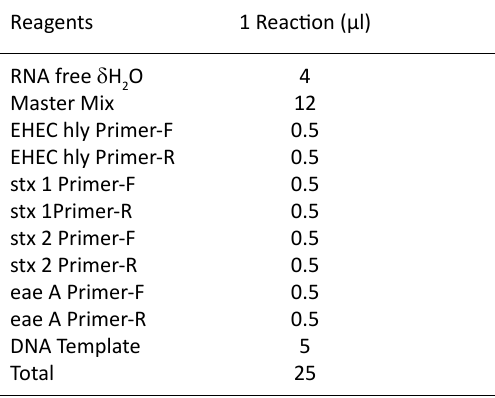
Table 2. PCR Master-mix